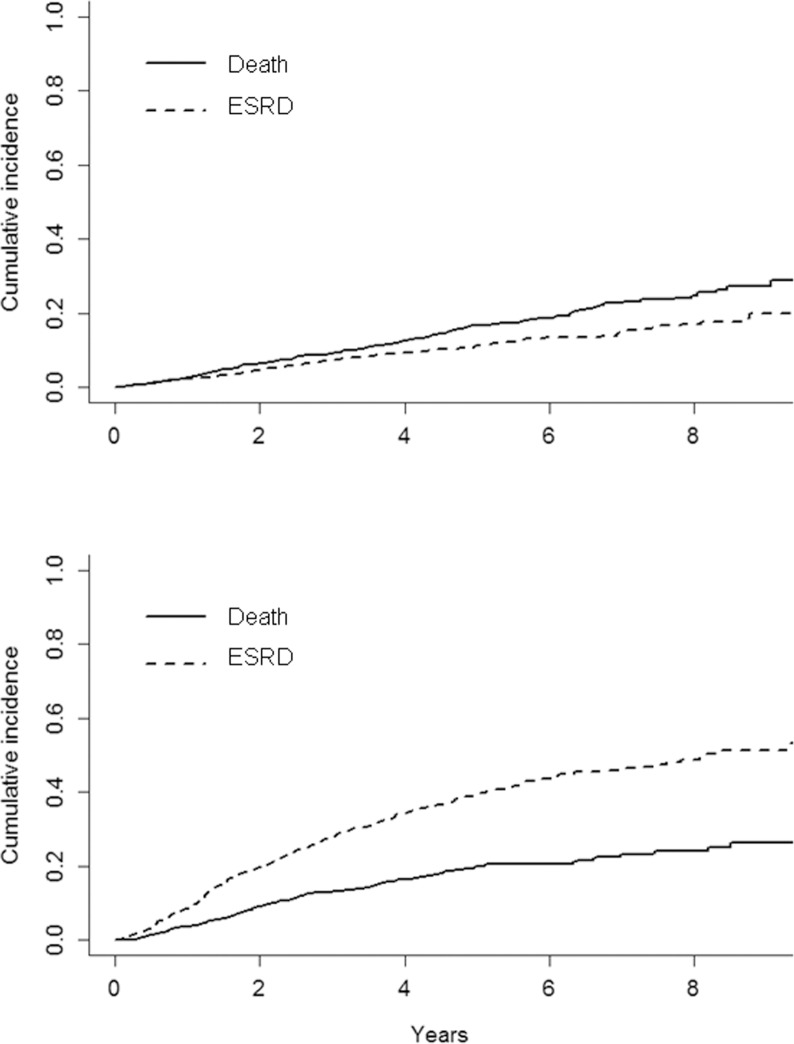
Cumulative incidence probability of ESRD and all-cause death before ESRD, by competing risk analysis, in LP (top) and CON (bottom) patients.P values were <0.0001 and 0.002 in LP and CON, respectively.